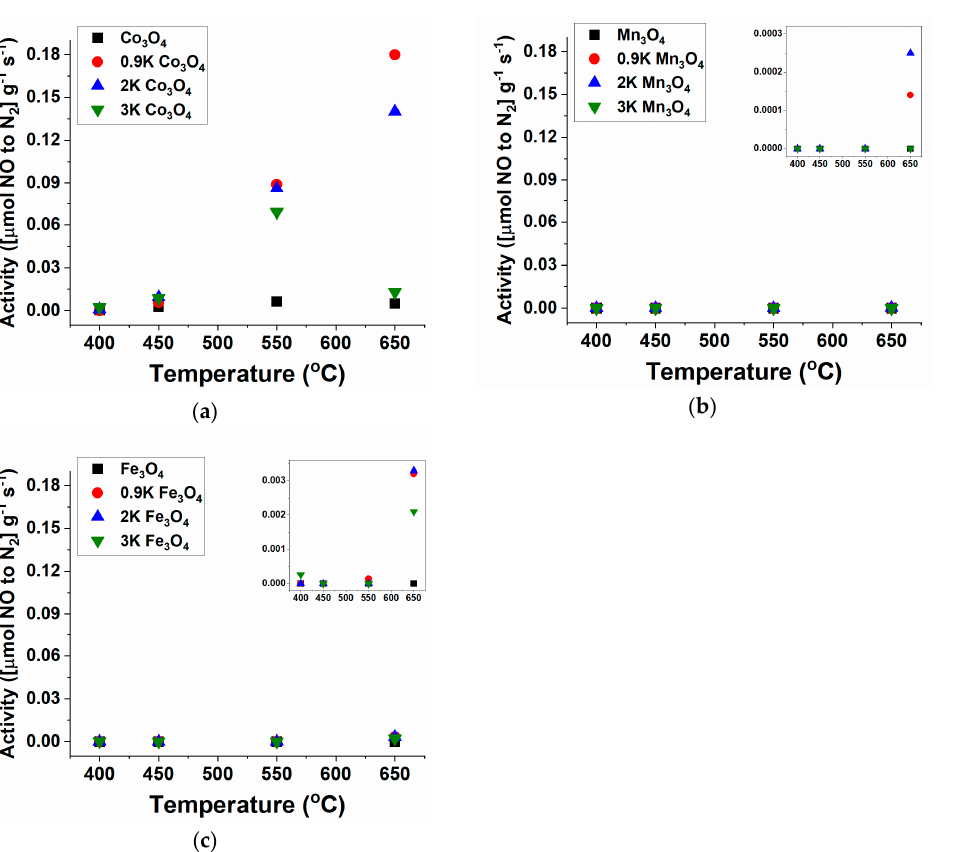
Figure 2. NO decomposition activity in units of [(µmol NO to N 2 ) g − 1 s − 1 ] as a function of temperature over ( a ) Co 3 O 4 -based catalysts, ( b ) Mn 3 O 4 -based catalysts, and ( c ) Fe 3 O 4 -based catalysts with varying amounts of K promotion (0–3 wt.% K); insets for (b) and (c) present the low activity regions (0–0.003